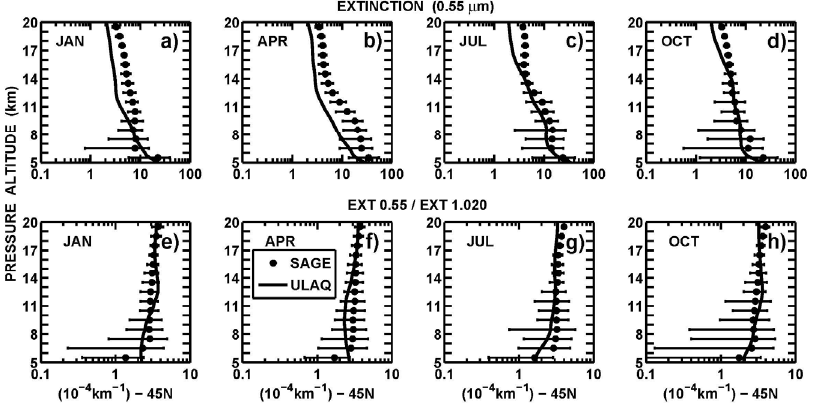
Figure 1. Extinction profiles at λ = 0.55 μ m (upper panels) and extinction ratio between wavelength channels at λ = 0.55 μ m and λ = 1.020 μ m (bottom panels): ULAQ calculations (solid line) and SAGE-II derived values (asterisks) are shown at 45N for January, April, July and October, from left to right panels, respectively (average 1996–2000).